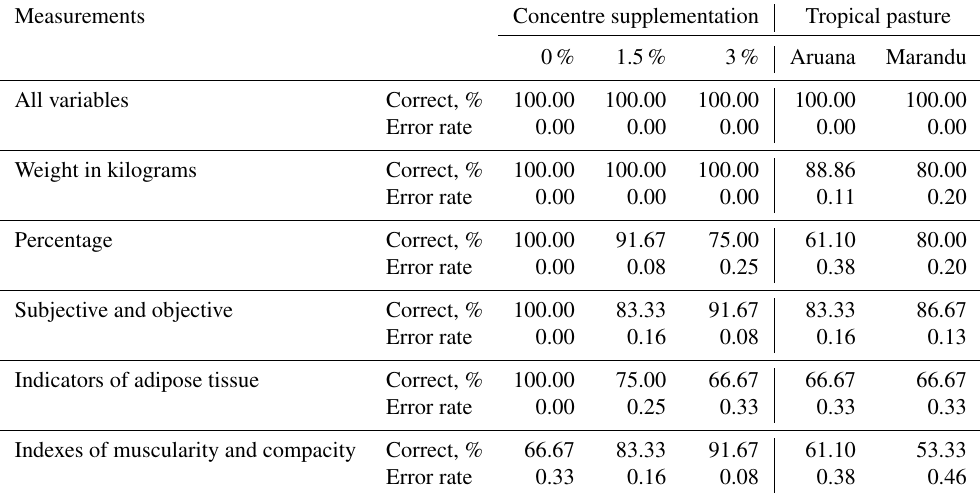
Table 6. Discriminant multivariate analysis with percentage of correct and error rate assigned to different concentrate supplementation and two types of tropical grass forage, using all variables, variables measured in kilograms, variables related to percentages, subjective and objective variables, variables related to adipose tissue, and variables related to muscularity and compacity of the